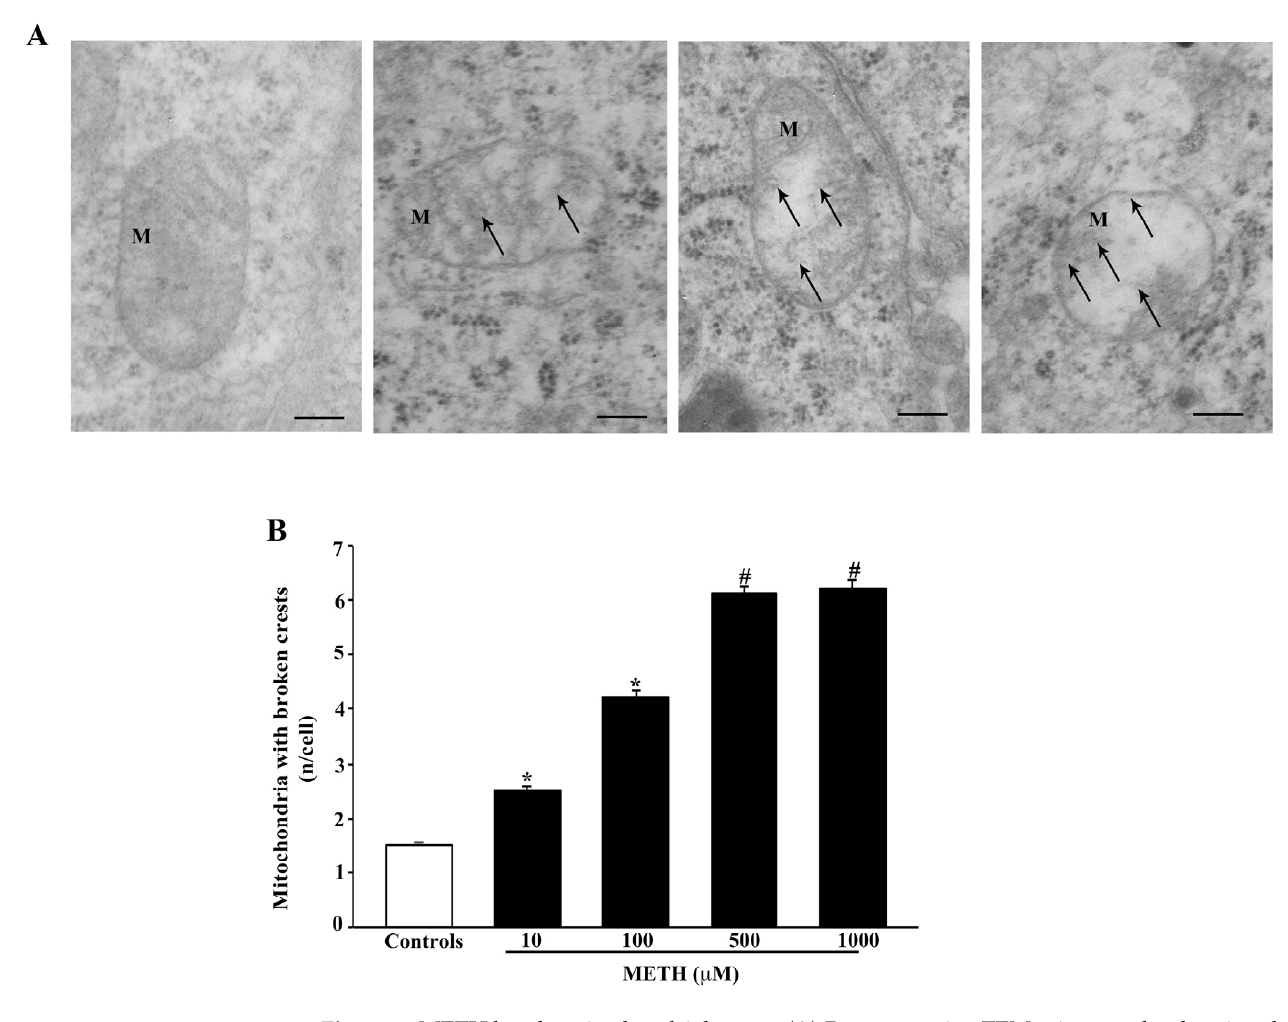
Figure 9. METH breaks mitochondrial crests. ( A ) Representative TEM micrographs showing that METH dose-dependently increases mitochondria (M) with broken crests (arrow). ( B ) The graph reports mitochondria with broken crests. Values are given as the mean ± S.E.M from N = 50 cells per group. * p ≤ 0.05 compared with controls; # p ≤ 0.05 compared with controls and METH 10 µ M and 100 µ M. Arrows point to broken crests. Scale bars = 160 nm.